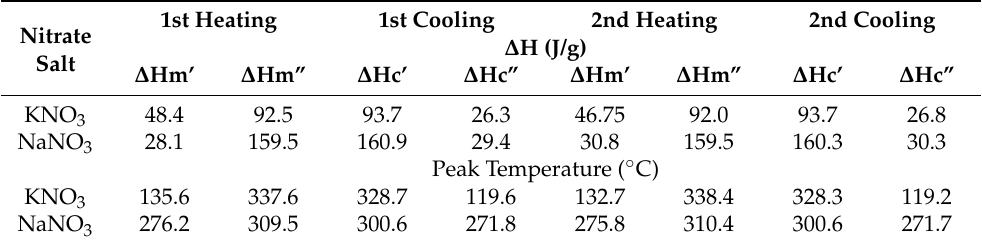
Figure 2. DSC curves of 1st (on the right) and 2nd (on the left) heating/cooling cycles for ( a ) KNO 3 and ( b ) NaNO 3 . The two curves are related to the heat flow behavior in the temperature range − 10 to 360 °C. Table 1. Calorimetric characteristics by DSC of the basic nitrate salts (transformation enthalpies and temperatures of the main peaks) .